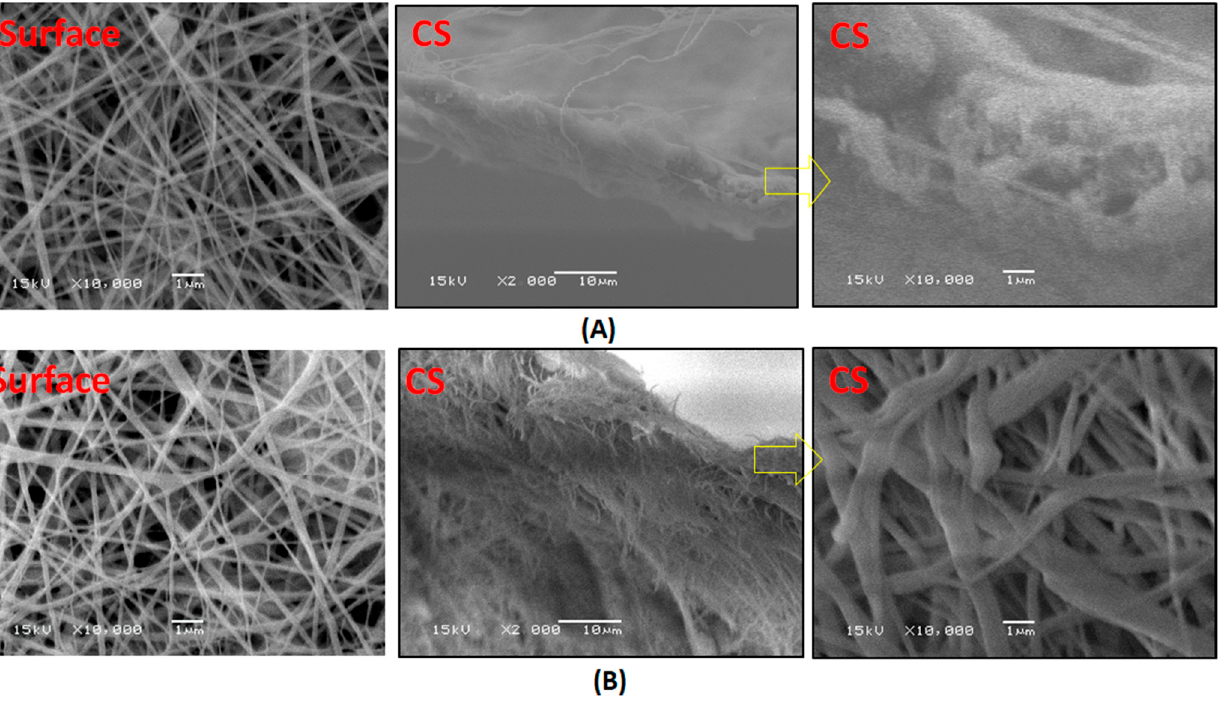
Figure 8. SEM images of PcH/PES blend membranes that were prepared using a 1 NMP: 9 DMF solvents mix and were treated by ( A ) heating at 60°C and ( B ) phase inversed at 40°C with LiCl additive. Surface images at ×10,000 and cross section images at ×2000 and ×10,000 were done.